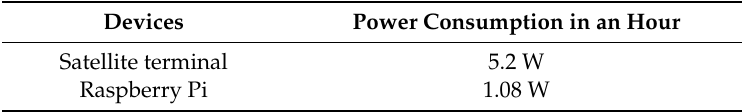
Table 6. The power consumption of the devices.